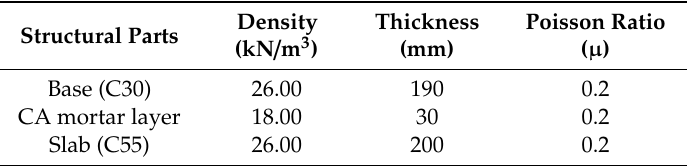
Table 1. Mechanical parameters of the track structure.